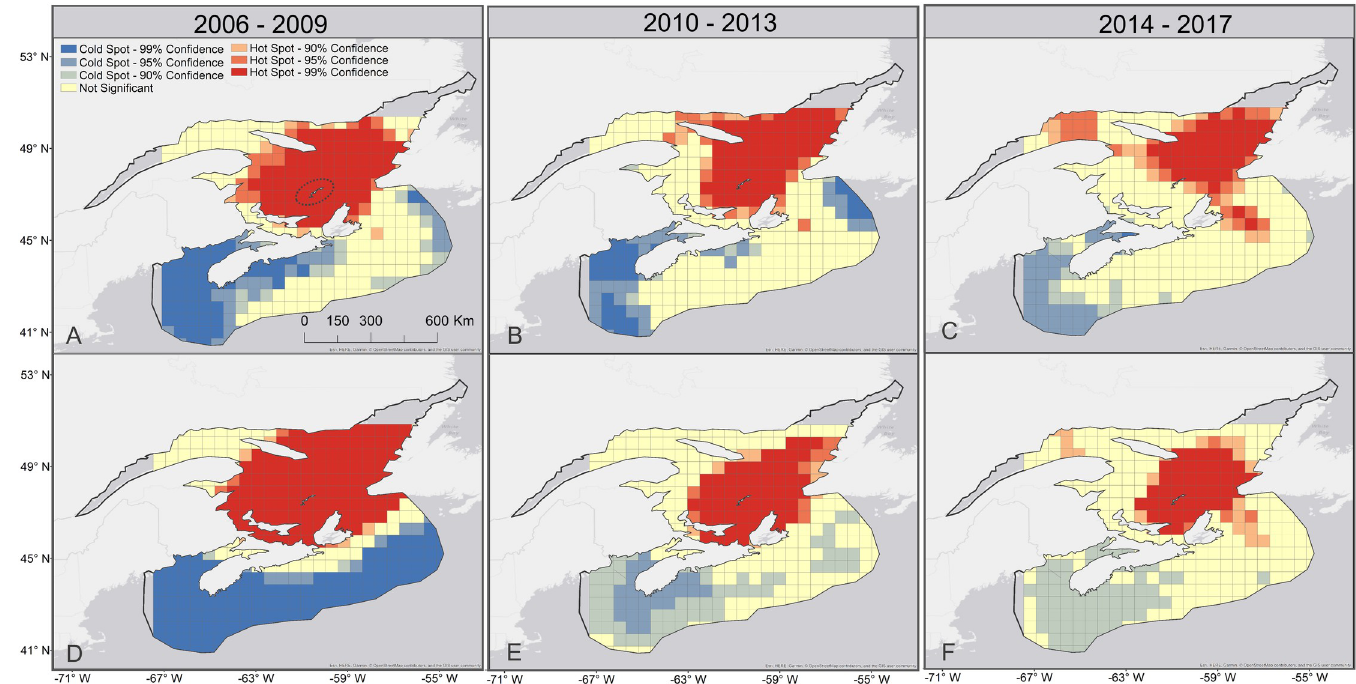
Fig 5. Optimized hot spot analysis of jellyfish occurrence (A—C), and jellyfish weight (kg) (D—F) in the groundfish surveys for 2006 to 2009 (A and D), 2010 to 2013 (B and E), and 2014 to 2017 (C and F). Magdalen Islands are circled within the Gulf of St. Lawrence (A).